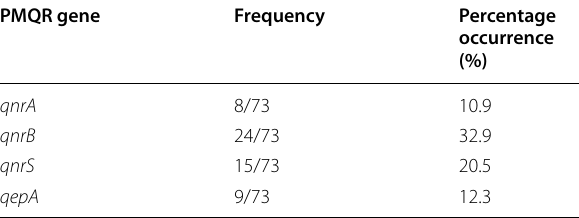
(36.9%) were Klebsiella spp., four (5.5%) were Pseu- domonas spp., while there were three isolates (4.1%) each of Proteus spp. and Enterobacter spp. There were two Acinetobacter spp. isolates (2.7%), with Citrobacter spp., Morganella spp. and Salmonella spp. having one isolate (1.4%) each. Forty-three of the total isolates carried at least one of the targeted PMQR genes (Table 2). The distribution of PMQR genes in the forty-three of the seventy-three UTI isolates showing the carriage of PMQR genes is shown in Table 3. Of the forty-three isolates showing the carriage of PMQR genes, 25 were Escherichia coli , 10 were Klebsiella spp., two each for Pseudomonas spp. and Proteus spp., while Enterobacter spp., Acinetobacter spp., Citrobacter spp. and Salmonella spp. had one isolate each. All the bacteria genera used in this study with the exception of the genus Morganella had at least one isolate showing the carriage of the tar- geted PMQR genes. The remaining thirty isolates did not carry any of the PMQR genes and were not presented in the Table. Eight of the isolates representing 10.9% of the total 73 ciprofloxacin-resistant bacteria carried the qnrA gene, Table 4 Frequency of occurrence of PMQR genes in the ciprofloxacin-resistant bacteria PMQR gene